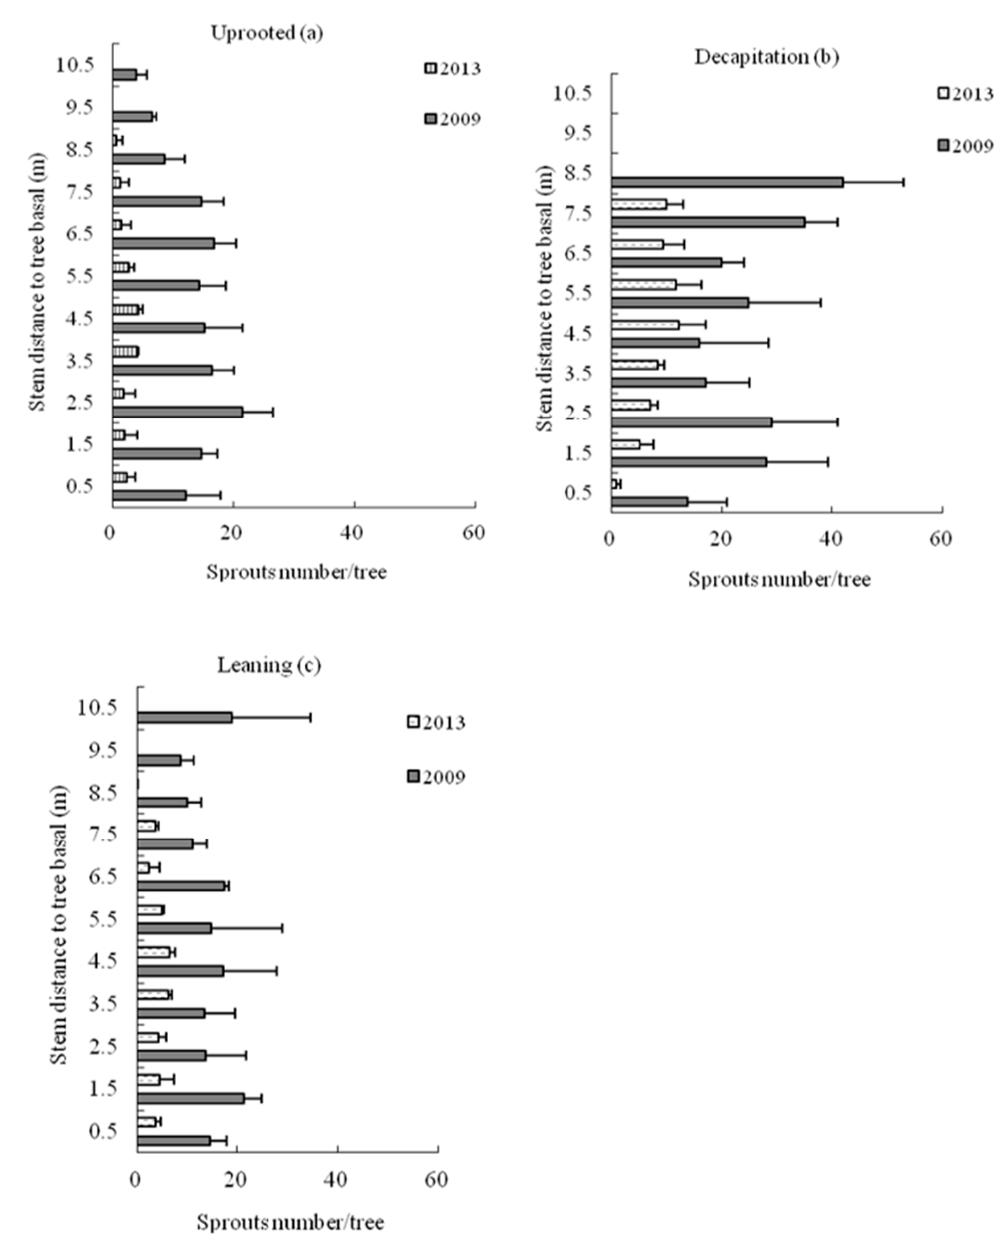
Figure 7. The sprout number per tree distribution on different section of tree stems for ( a ) uprooted , ( b ) decapitation and ( c ) leaning trees of S. superba in 2009 and 2013, respectively.